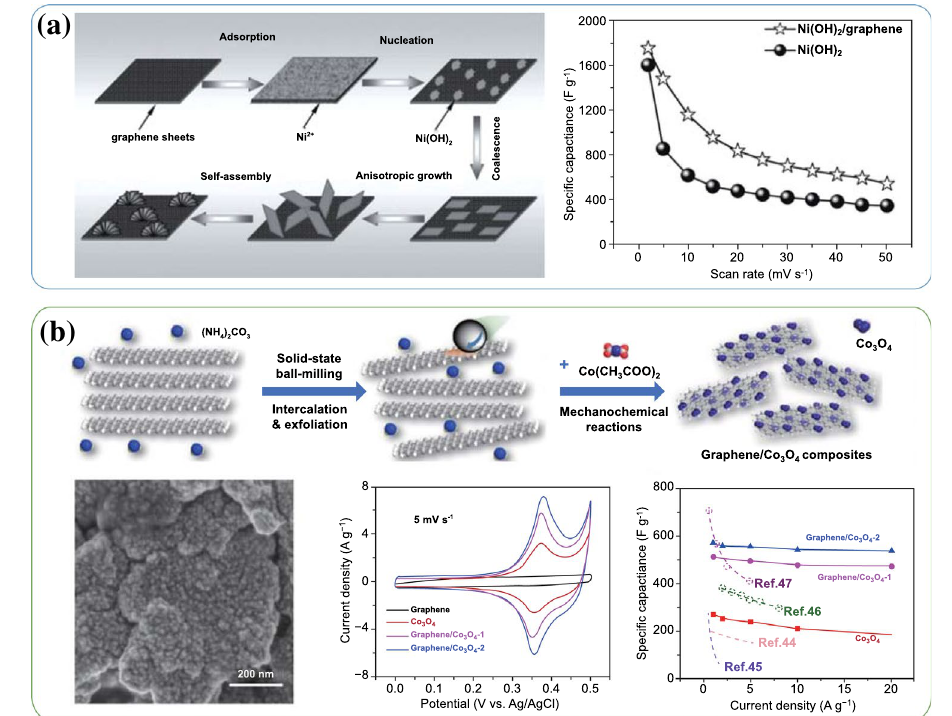
Fig. 5 a Schematic illustration for the possible formation of the Ni(OH) 2 /graphene and the specific capacitances of Ni(OH) 2 /graphene and Ni(OH) 2 at different scan rates. Adapted with permission from Ref. [38] Copyright 2012 Wiley–VCH. b Schematic illustration for the prepara- tion of graphene/Co 3 O 4 composites, SEM images of graphene/Co 3 O 4 -2, CV curves at 5 mV s −1 of graphene, Co 3 O 4 , graphene/Co 3 O 4 -1 and graphene/Co 3 O 4 -2, and their specific capacitances at various current densities. Adapted with permission from Ref. [41] Copyright 2020